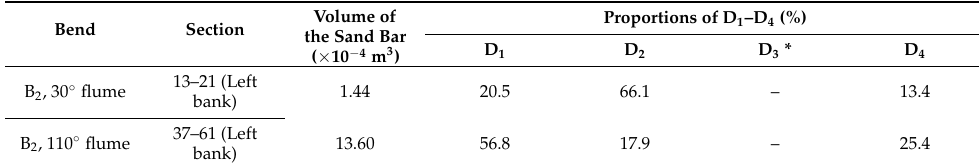
Table 4. Composition of point bars in the left bank of Bend B 2